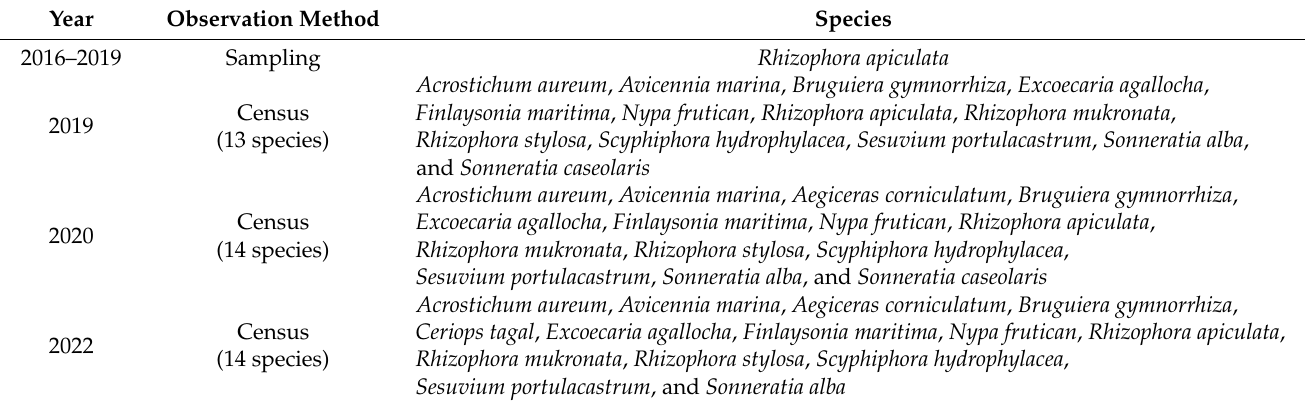
Table 2. Species found in the Lubuk Kertang restored area in 2016–2022 planted with